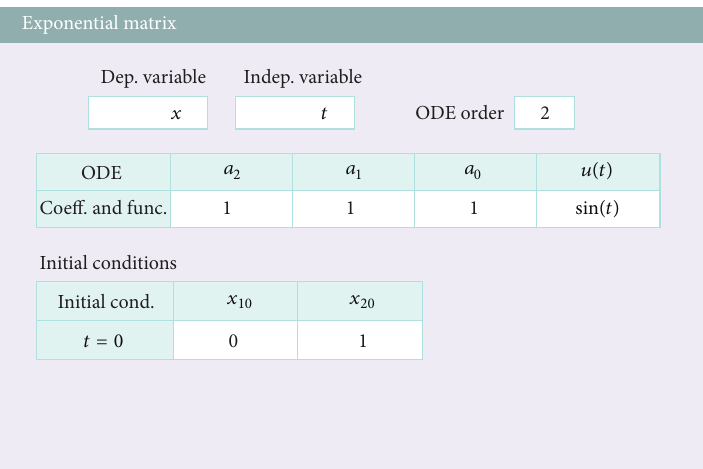
Figure 2: The first window shown by the symbolic processor allows us to introduce the parameters which define the differential equation to be solved, including the initial